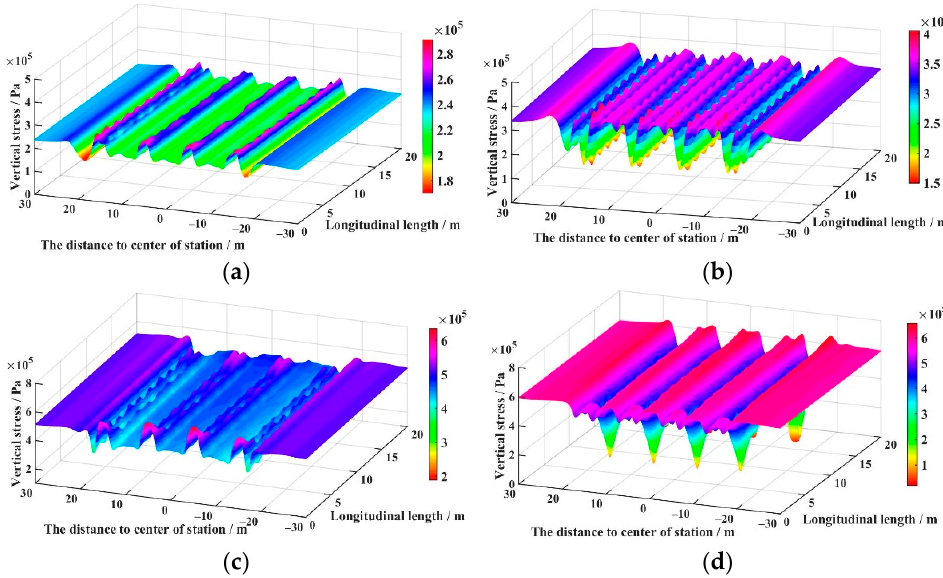
Figure 5. Stress fields of scheme 1 (S—2-3-1-4-6-7-5-8): ( a ) P1 (z = 4.5 m), ( b ) P2 (z = 0 m), ( c ) P3 (z = − 8.3 m), and ( d ) P4 (z = − 12.8 m).